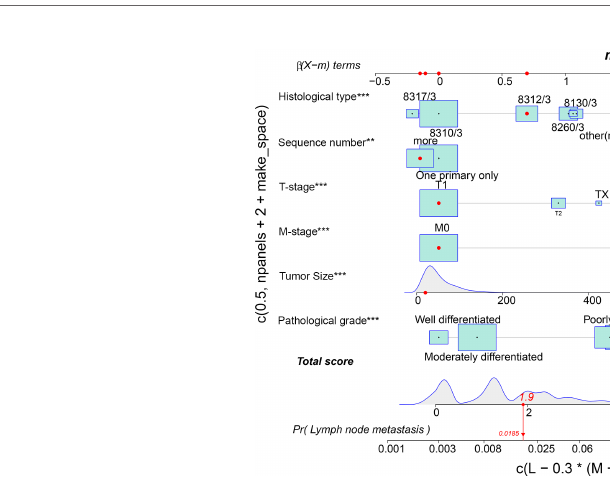
FIGURE 1 | A nomogram for predicting the risk of lymphatic metastasis in patients with kidney cancer. 8317/3 represents chromophobe renal cell carcinoma, 8310/ 3 represents clear cell adenocarcinoma, 8312/3 represents renal cell carcinoma, 8260/3 represents papillary adenocarcinoma, 8130/3 represents papillary transitional cell carcinoma, 8120/3 represents transitional cell carcinoma, and other represents the number of patients is less than 1,000. Independent factors, **, <0.01; ***,<0.001.